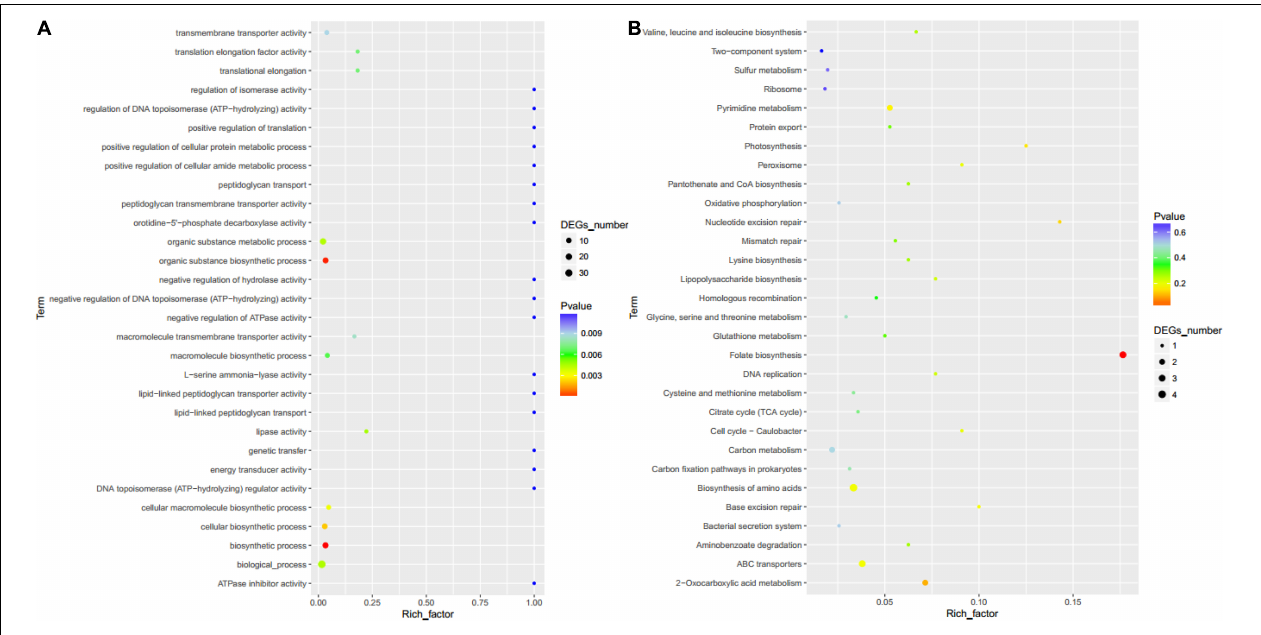
FIGURE 8 | GO enrichment map (A) and KEGG enrichment map (B)